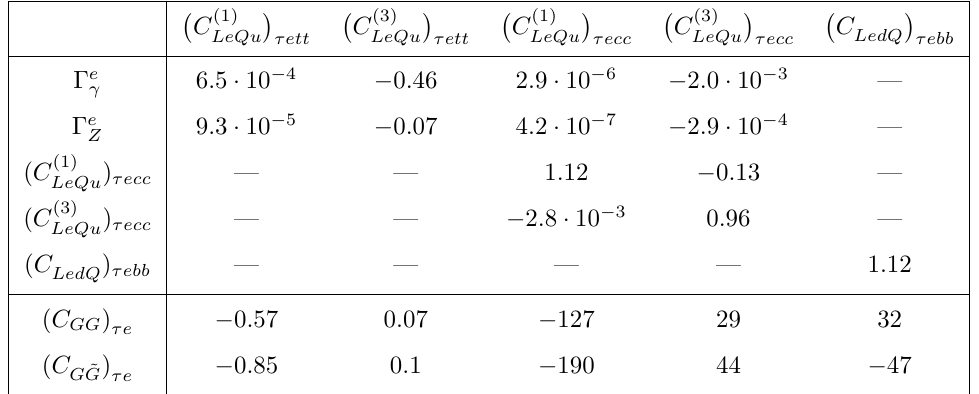
Table 20 . The Wilson coefficients of dipole, scalar and tensor operators at µ = m t induced by a nonzero top-, bottom- and charm-quark scalar and tensor operators through operator mixing. The starting point of the running is taken at Λ = 1 TeV. The threshold corrections to C are given in eqs. (3.22), (3.23), (7.13a), (7.13b). We evaluate them at µ = m (bottom) quark while µ = 2 GeV for the charm